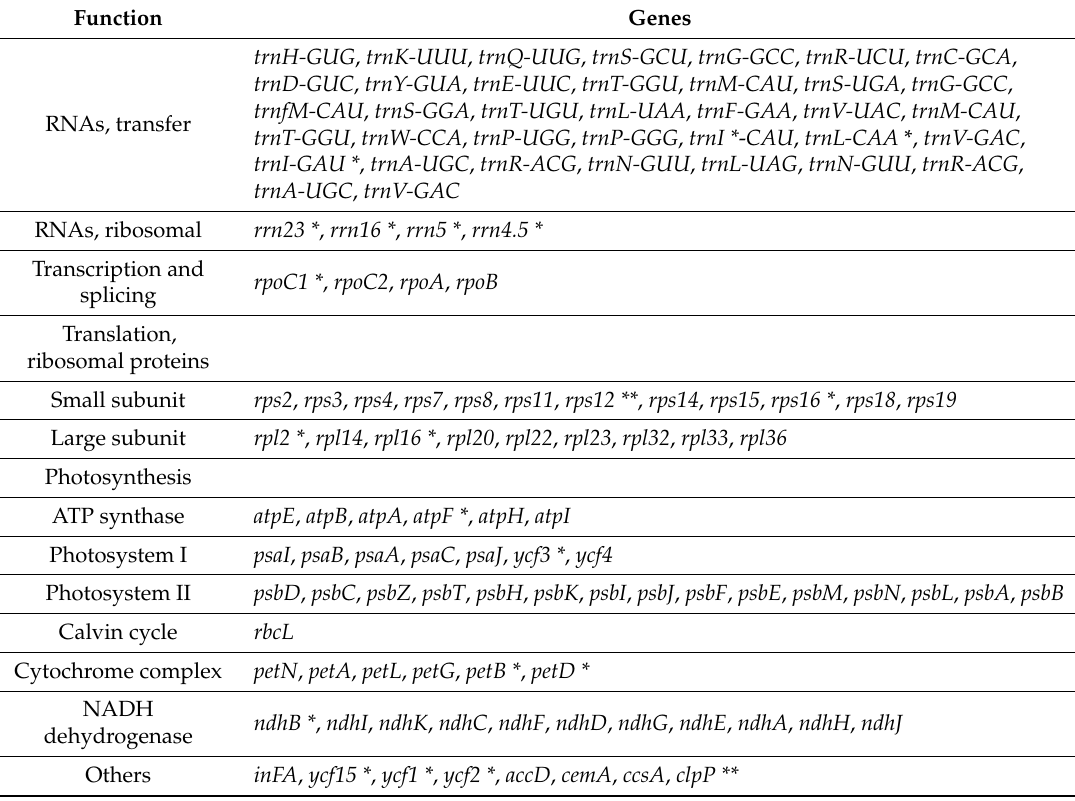
Table 3. List of genes annotated in the cp genomes of Q. acutissima sequenced in this study. Function